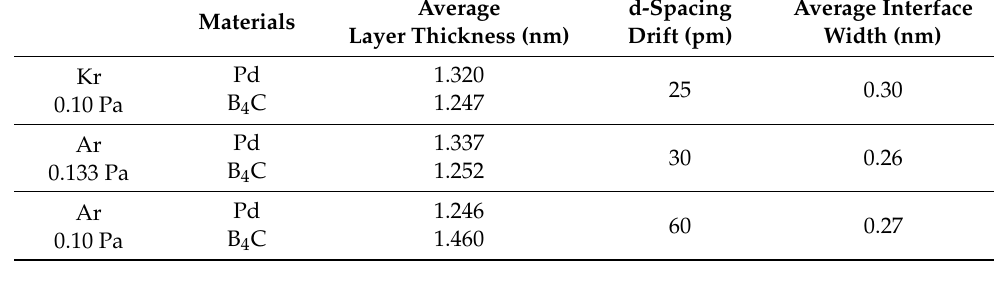
Figure 1. Grazing incidence X-ray reflectometry (GIXR) measurement and fitted results of the Pd/B 4 C multilayers with 50 bilayers fabricated by Ar at 0.10 Pa ( a , d ), Ar at 0.133 Pa ( b , e ), and Kr at 0.10 Pa ( c , f ). Table 1. Fitted layer structure parameters of the Pd/B 4 C multilayers with 50 bilayers.